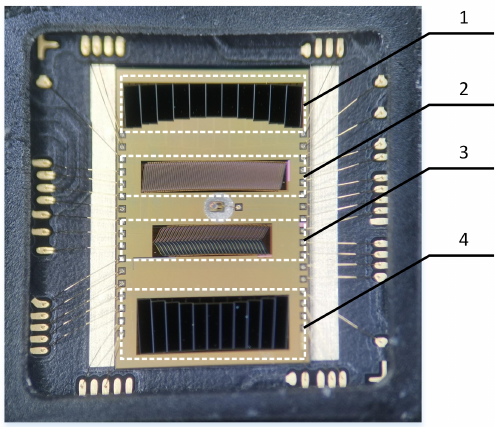
Figure 6. Photo of